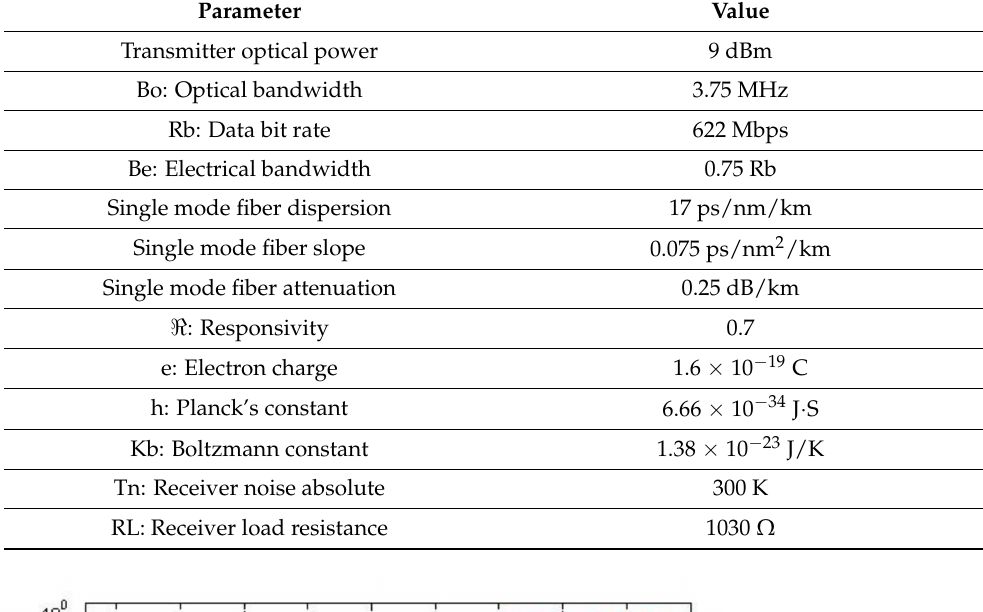
Table 6. System parameters.